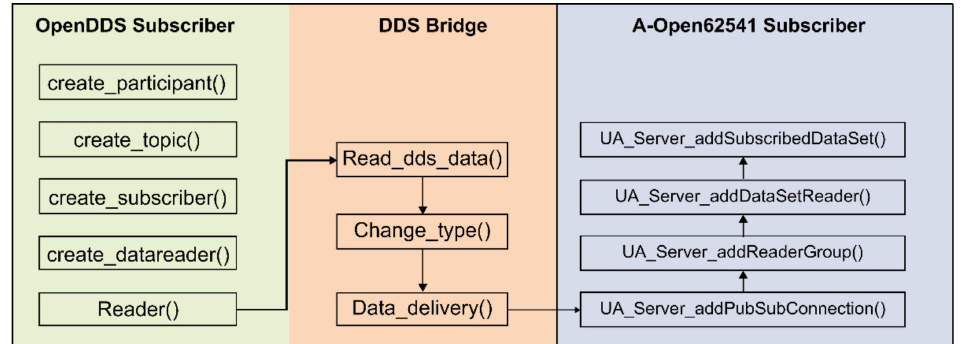
Figure 11. DDS bridge